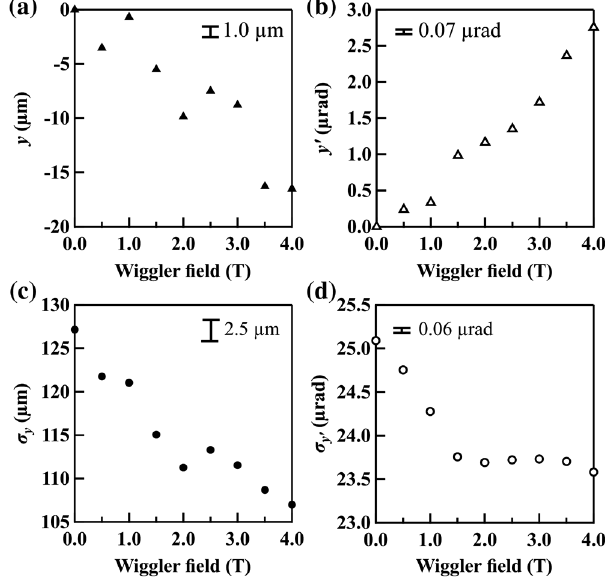
FIG. 6. Extracted (a) y , (b) y 0 , (c) σ y , and (d) σ 0 y at the BMIT bend magnet as a function of the magnetic field of the BMIT wiggler. The error bars are the standard deviation of eight measurements of 3 s